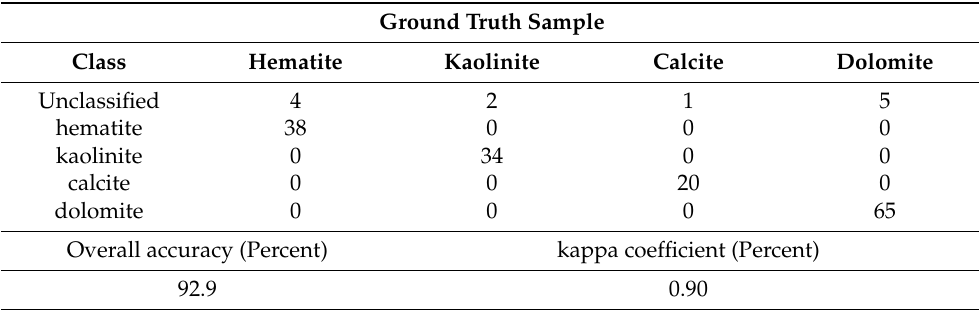
Table 7. The accuracy assessment of the MTMF mapping method for hydrothermal alteration minerals based on GF-5